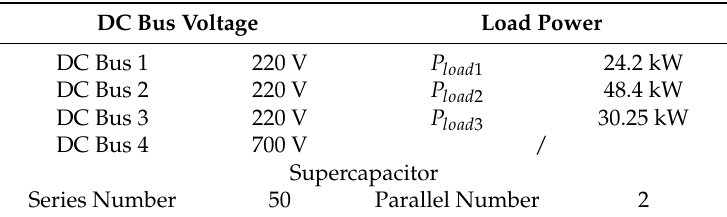
Table 2. Simulation parameters of DC Bus voltage and DC load power.